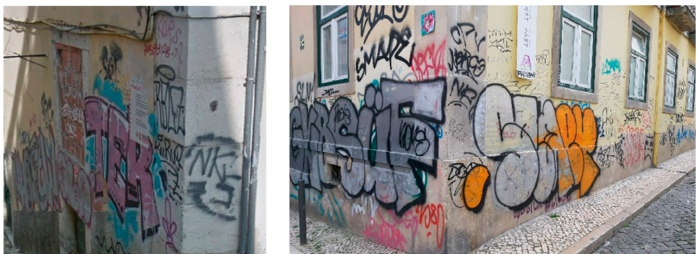
Figure 9. Examples of images removed from the dataset used for the graffiti detection model.